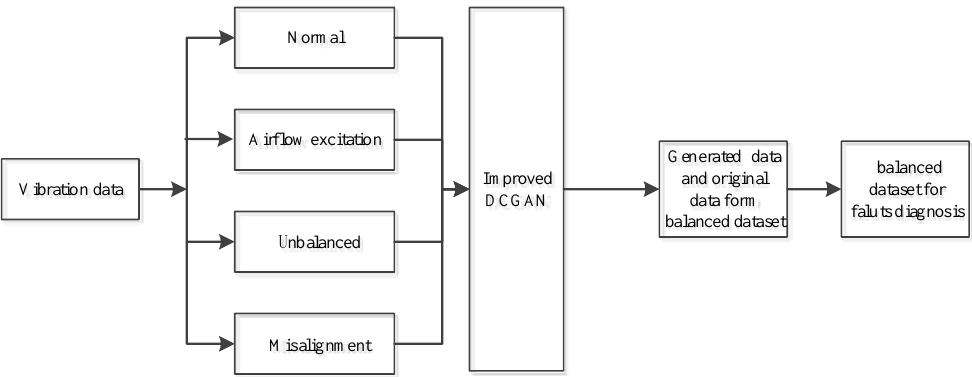
Figure 12. Fault data generation and classification of gas turbine rotor system. Table 3. Number of training dataset and testing dataset